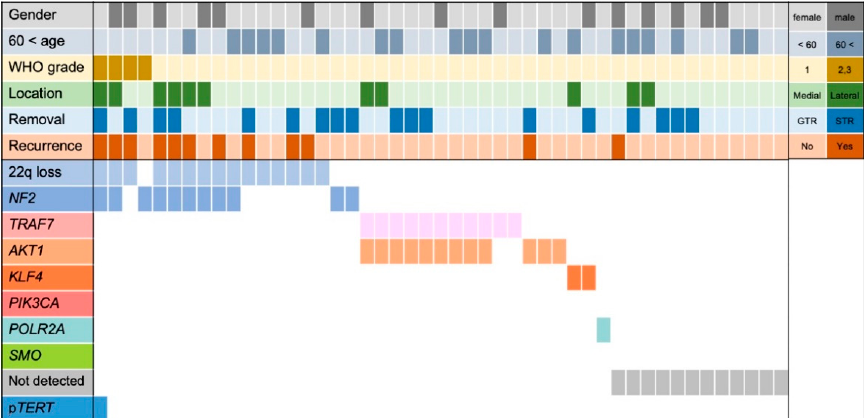
Figure 1. Clinical characteristics and genetic status of patients with sphenoid wing meningiomas.